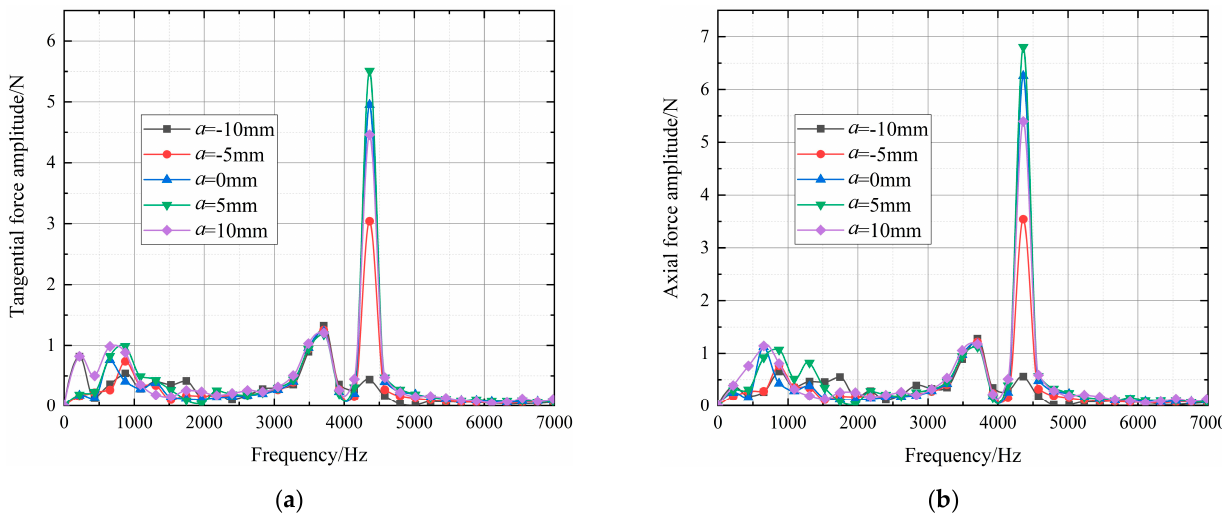
Figure 10. Frequency domain distribution of aerodynamic exciting force under design conditions. ( a ) Tangential aerodynamic exciting force; ( b ) Axial aerodynamic exciting force. Table 4. Exciting force under design conditions.